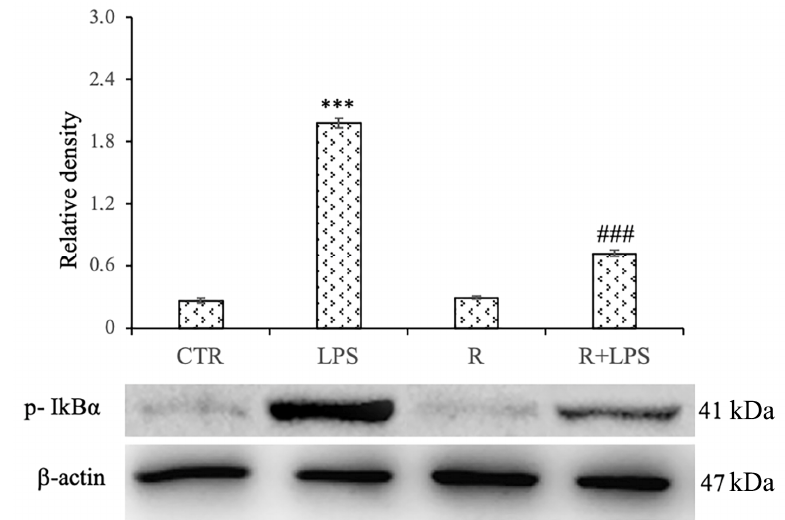
Figure 6. Effects of resveratrol on the LPS-induced phosphorylation of IkB- α in N13 microglial cells treated with LPS for 72 h. Western blotting detection and densitometric analysis of p-IkB α expression levels in the N13 cells of control (CTR), LPS (100 ng/mL), resveratrol (10 μ M) (R), and resveratrol plus LPS (R + LPS). For protein expression analysis data are expressed as arbitrary units after normalization against β -actin, which was used as a loading control. *** p < 0.001 LPS vs. CTR, ### p < 0.001 R + LPS vs. LPS.